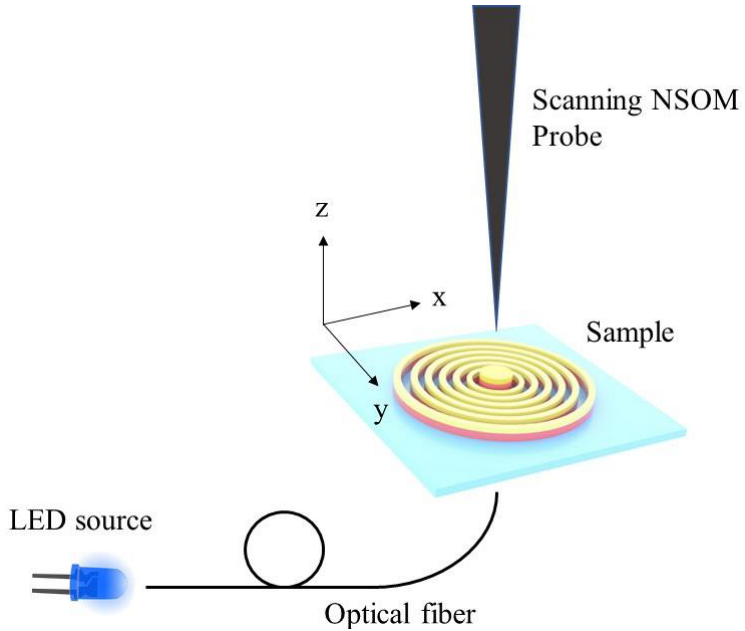
Figure 5. Measurement scheme of NSOM of MRZ structure excited by single-mode optical fiber (SMF) coupled to the LED of a different wavelength.